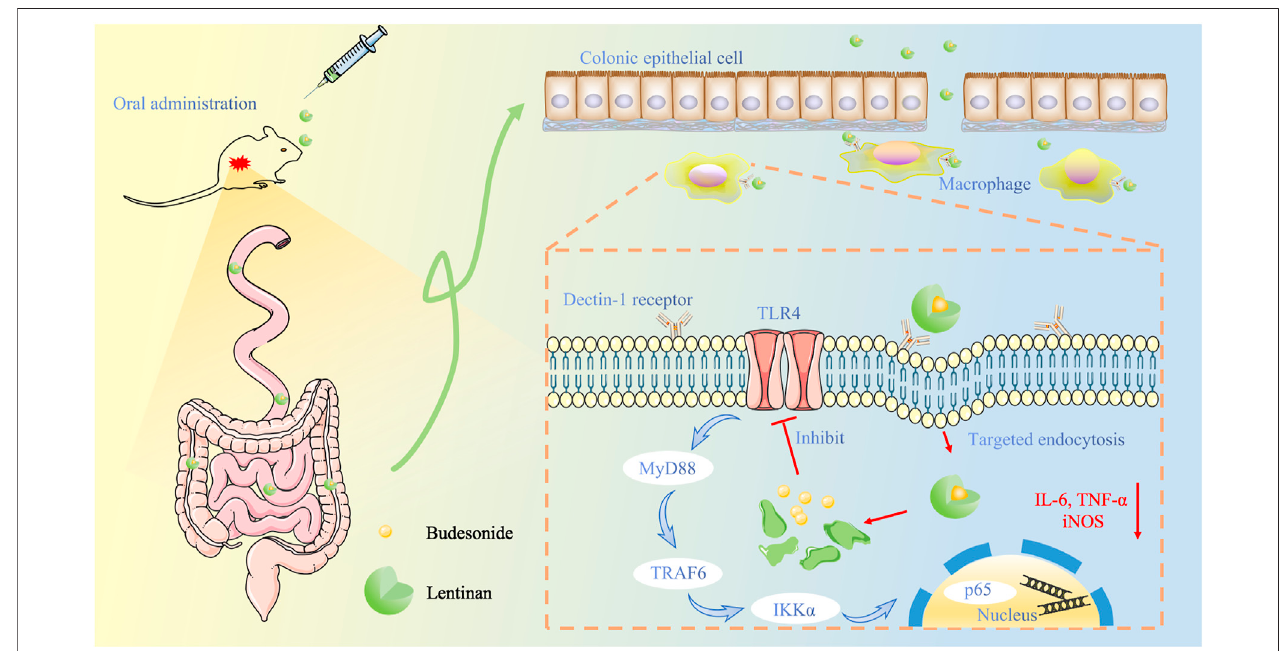
FIGURE 8 | Schematic illustration of lentinan-based oral nanoparticle loaded budesonide with macrophages-targeting ability for treatment of ulcerative colitis.